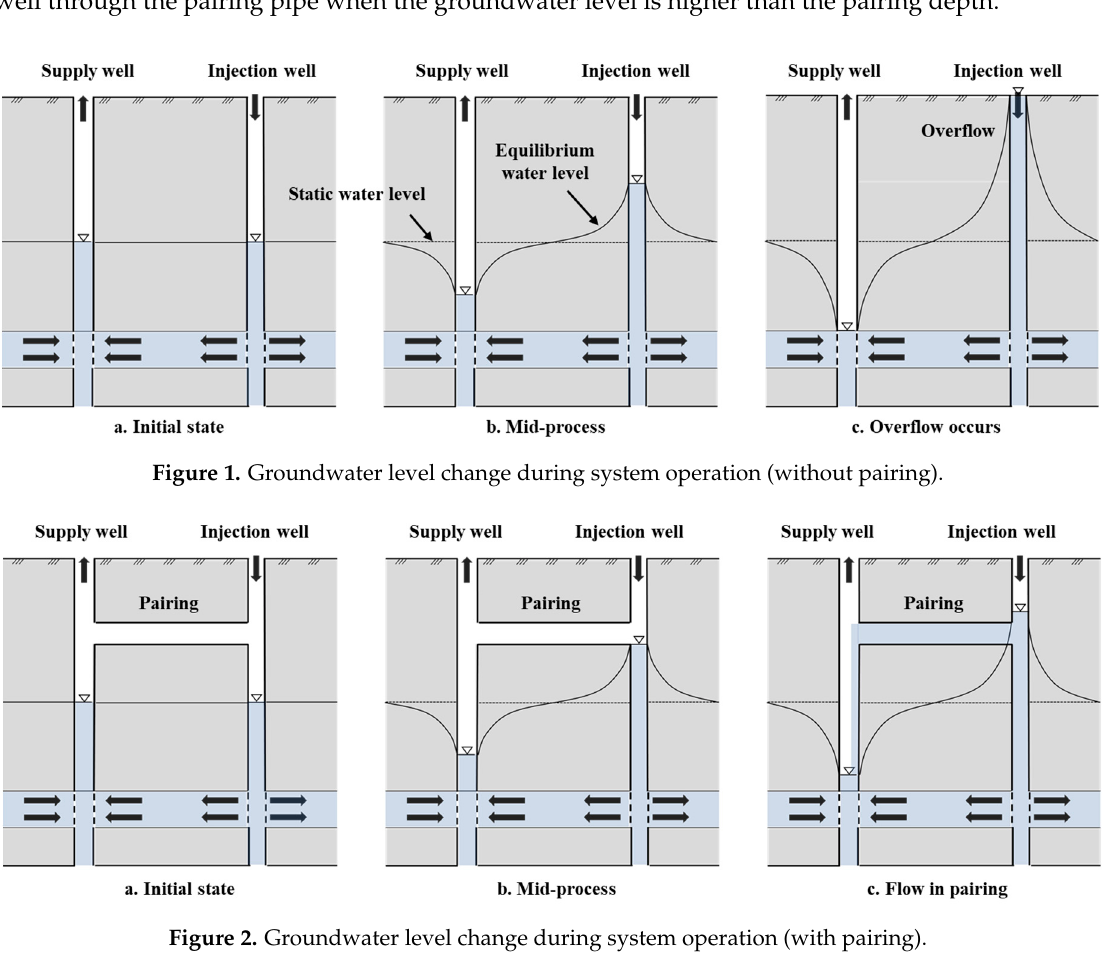
Figure 2. Groundwater level change during system operation (with pairing).